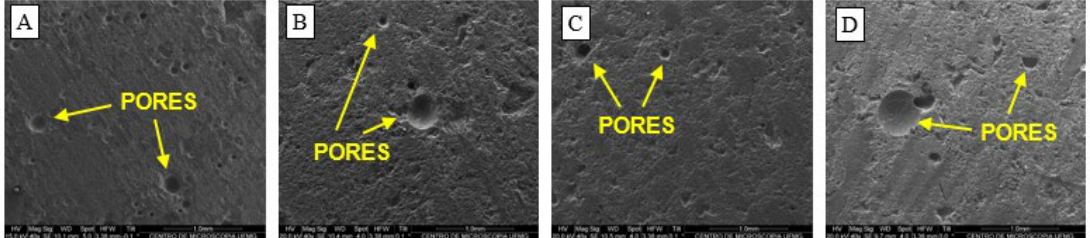
Figure 6. Images generated by SEM (SE) with a magnification of 40 times for the four consolidation conditions: w/c 0.55 –